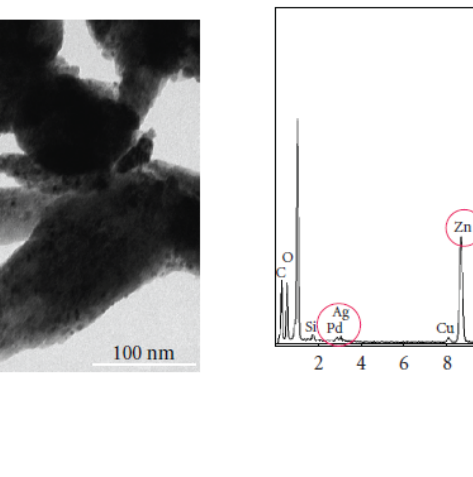
Figure 6. TEM image and EDS spectra for the Pd-Ag bimetallic nanoparticles